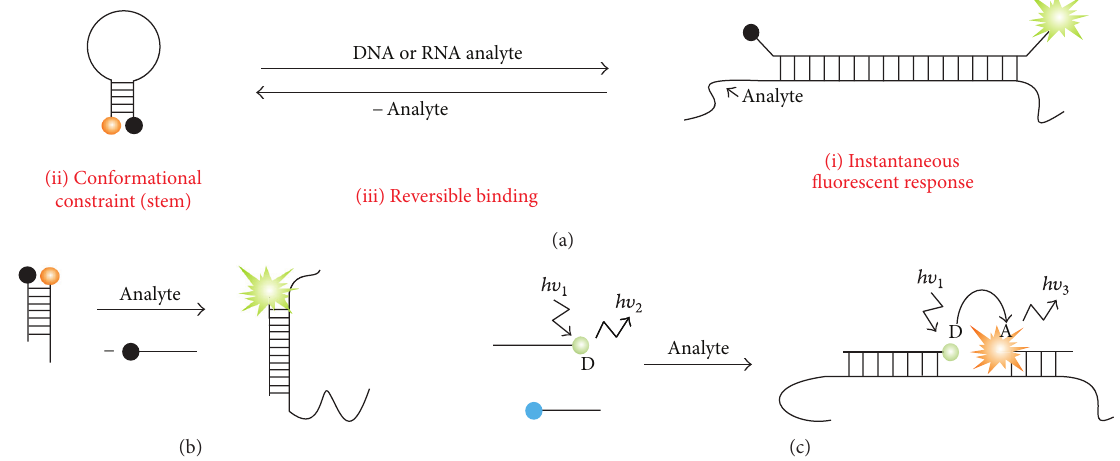
F 1: Instantaneous hybridization probes. (a) Classical design of molecular beacon (MB) probe [1–3]. Some important features of the probe are (i) the ability to produce instantaneous �uorescent signal; (ii) conformational constraint in the form of a stem loop in the target- unbound state (le); (iii) reversibility of hybridization. (b) Strand displacement probes [7–10]. e quencher-conjugated strand is displaced from the complex with the �uorophore-conjugated DNA by the analyte. (c) Adjacent probes [11–15]. Hybridization of two �uorophore- conjugated DNA probes to the adjacent positions of an analyte results in Förster resonance energy transfer (FRET). e hybridization efficiency is assessed as a difference in donor and acceptor